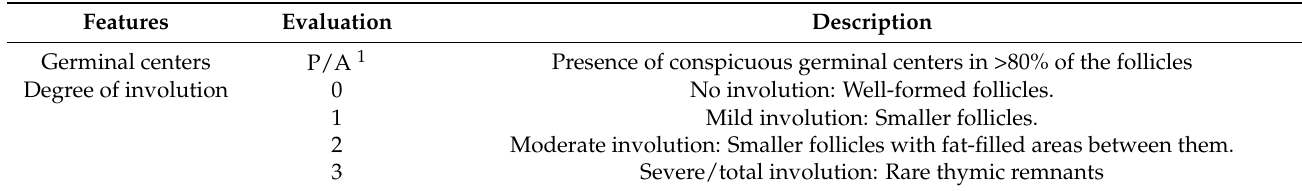
Table A11. Histopathological features evaluated in the thymus.